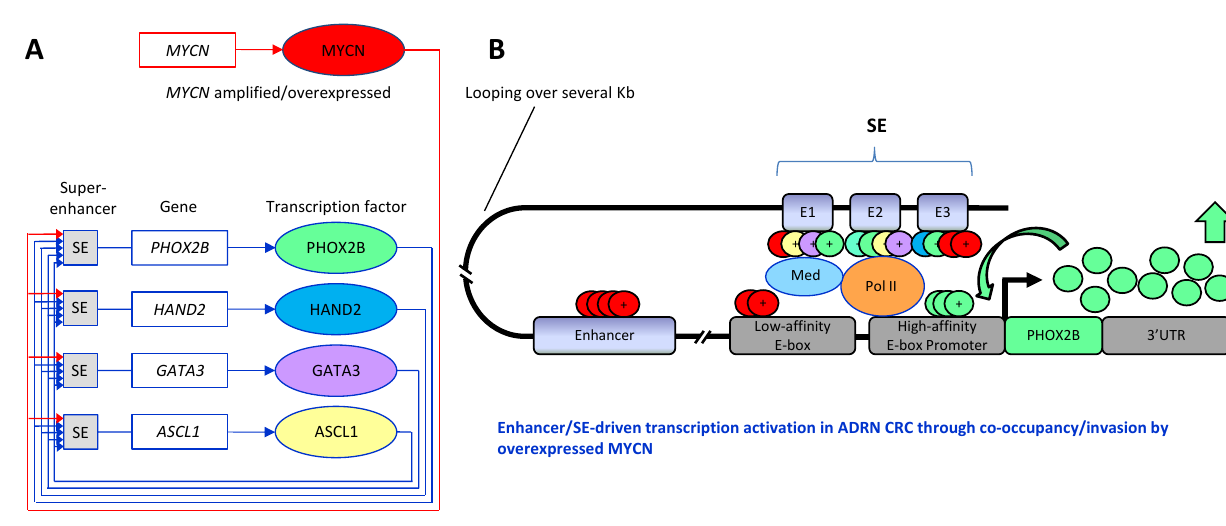
Figure 7. Enhancer/super-enhancer-driven transcription of ADRN CRC TFs by overexpressed MYCN. ( A ) Schematic representation of the ADRN CRC composed of a set of super-enhancer (SE)-associated lineage TFs (i.e., PHOX2B, GATA3, HAND2, ASCL1) co-occupied/invaded by MYCN (red arrows) following MYCN amplification/overexpression. The TFs (ovals) binds each other’s SE and induce a powerful feed ‐ forward loop over all the other genes. ( B ) Structural drawing of the molecular interactions within the ADNR CRC: the PHOX2B gene is given as an example. Starting from the 5 ′ end, PHOX2B SE consists of three E-boxes, bound by all TFs taking part in the CRC and by MYCN. In addition, overexpressed MYCN activates the PHOX2B enhancer and PHOX2B positively self-regulates its transcription by interacting with its own promoter in a positive autoregulatory loop.